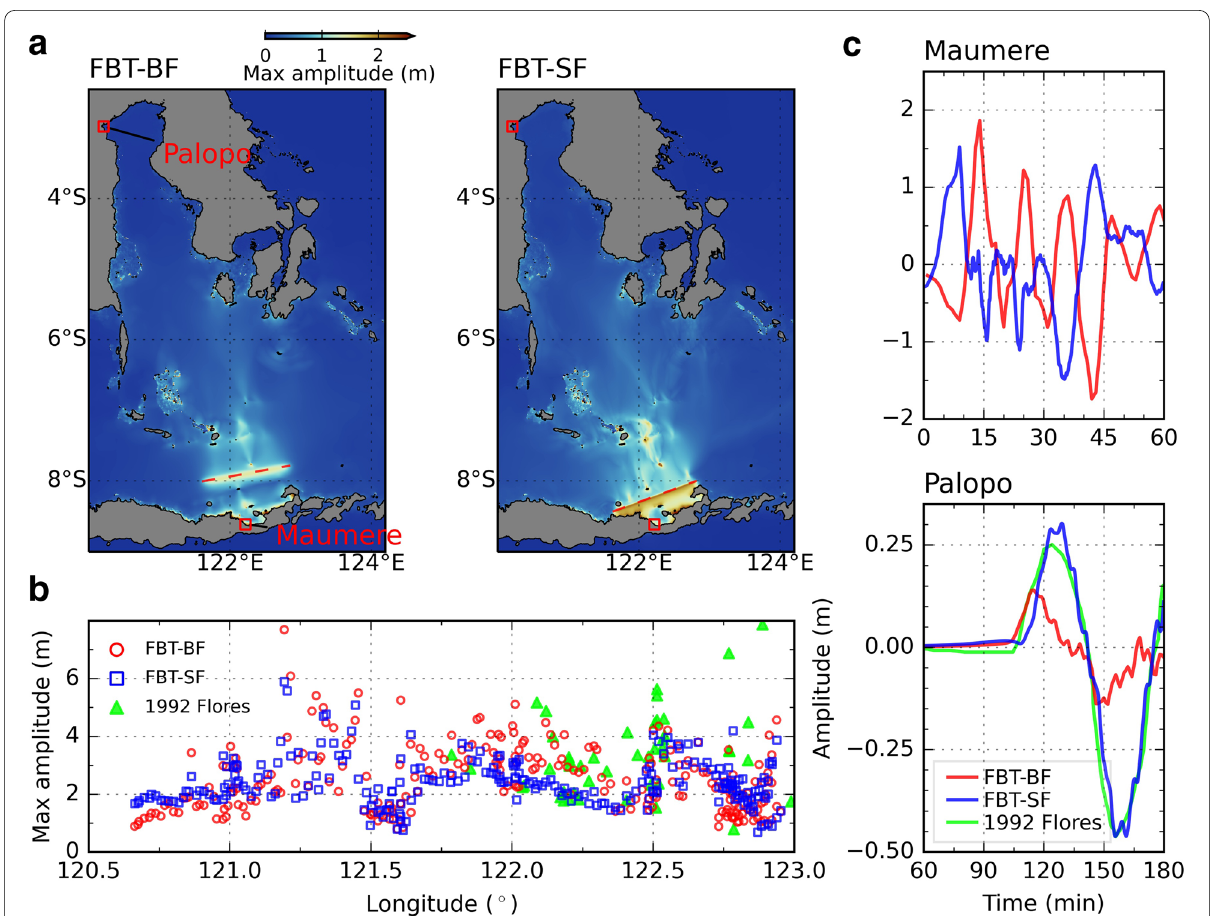
Fig. 4 Simulations of the tsunami generated in the Flores Sea from an Mw7.8 earthquake on the Flores back-arc thrust basal fault (FBT-BF) and splay fault (FBT-SF) scenarios. a Simulated maximum tsunami amplitude; the red dashed line shows top projection of the fault plane. b Coastal tsunami height along the northern shore of Flores Island at isobath 1 m. c Tsunami waveform at Maumere and Palopo gauges. Tsunami heights and waveform of the 1992 Flores event were obtained from Tsuji et al. (1995) and Hidayat et al. (1995),